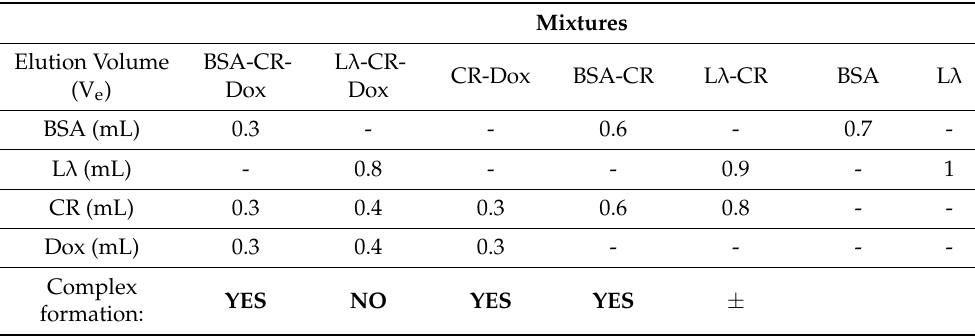
Table 2. Gel-filtration chromatography: elution volume (V e ) of BSA, L λ , CR, and Dox in mixtures of BSA-CR-Dox, L λ -CR-Dox, CR-Dox, BSA-CR, L λ -CR, and in free BSA and L λ (Biogel P-300).